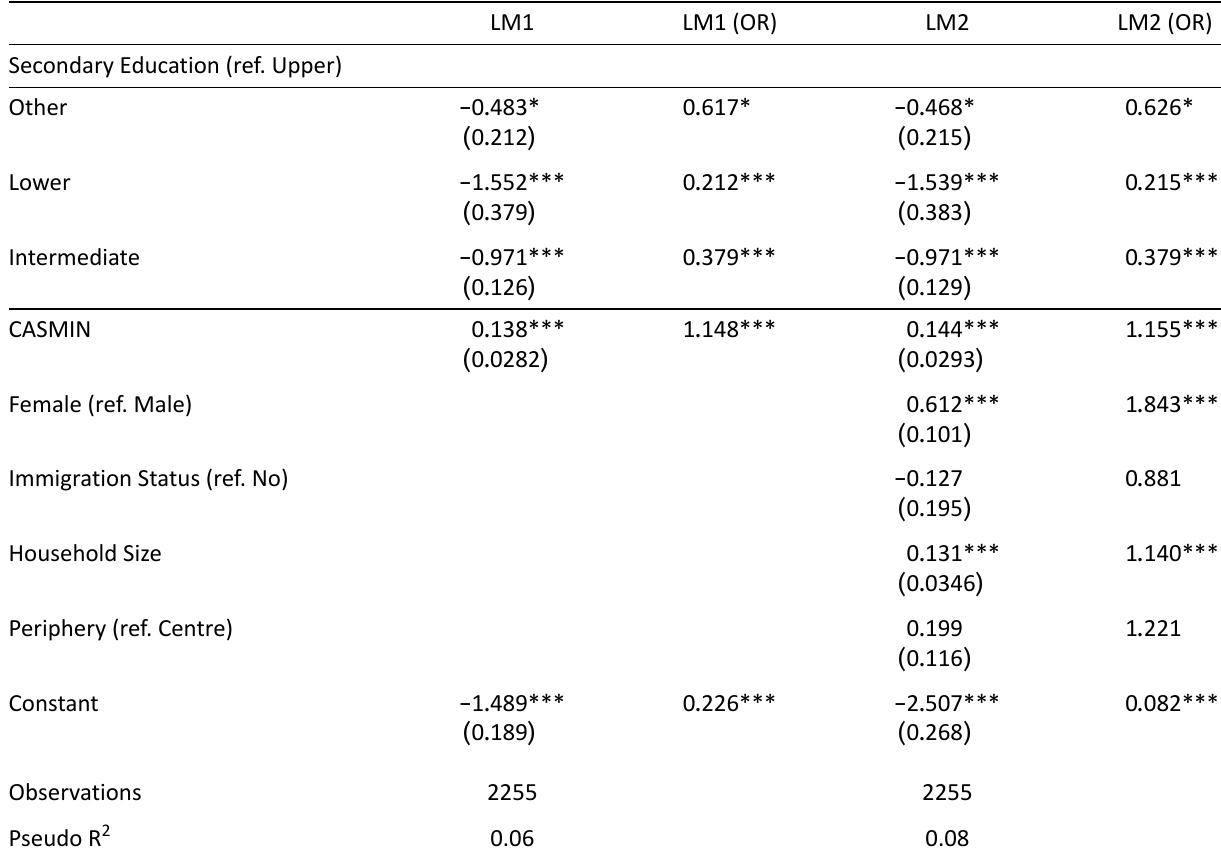
Figure 1. Predicted probabilities (predictive margins with 95% CIs) for potential protest participation by NCE. Table 3. Logistic regressions on